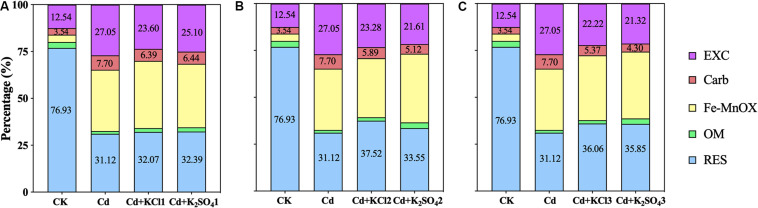
Effect of different types and application amounts of K on Bio-Cd content in P. notoginseng planting soil (A) denoted low application amount, KCl1: 0.171, K2SO41: 0.2 g⋅kg–1; (B) denoted medium application amount, KCl2: 0.513, K2SO42: 0.6 g⋅kg–1; (C) denoted high application amount, KCl3: 1.026, K2SO43: 1.2 g⋅kg–1. Bio-Cd content is the sum of F(EXC) and F(Carb) Cd.